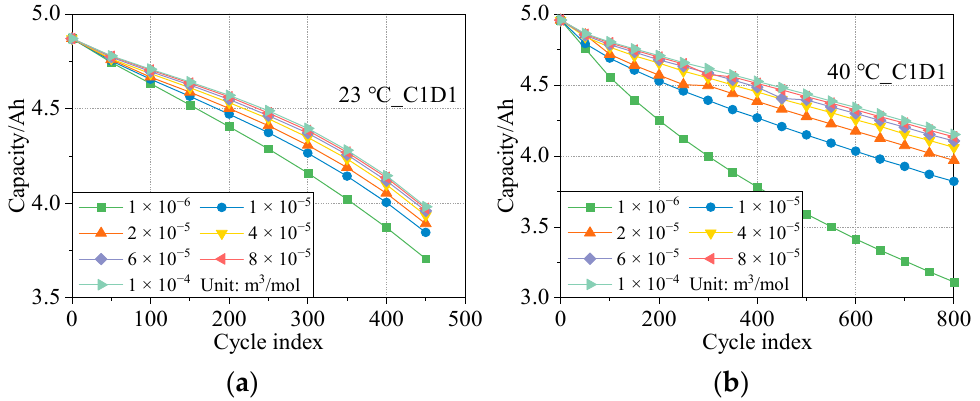
Figure 14. Simulation results of capacity loss when using different SEI molar volumes at ( a ) 23 °C and ( b ) 40 °C.